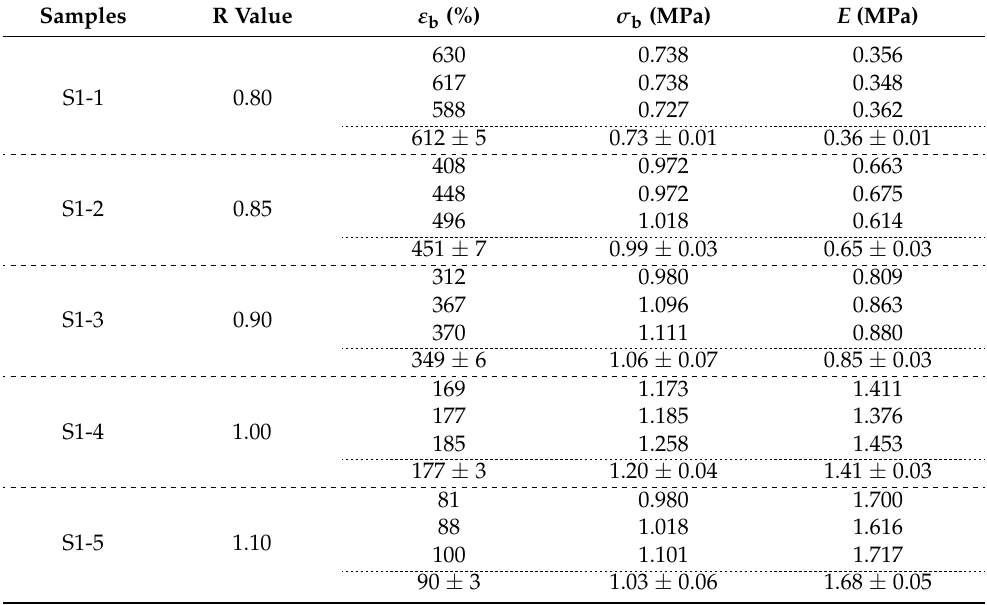
Table 5. Mechanical properties of elastomers with different R values.